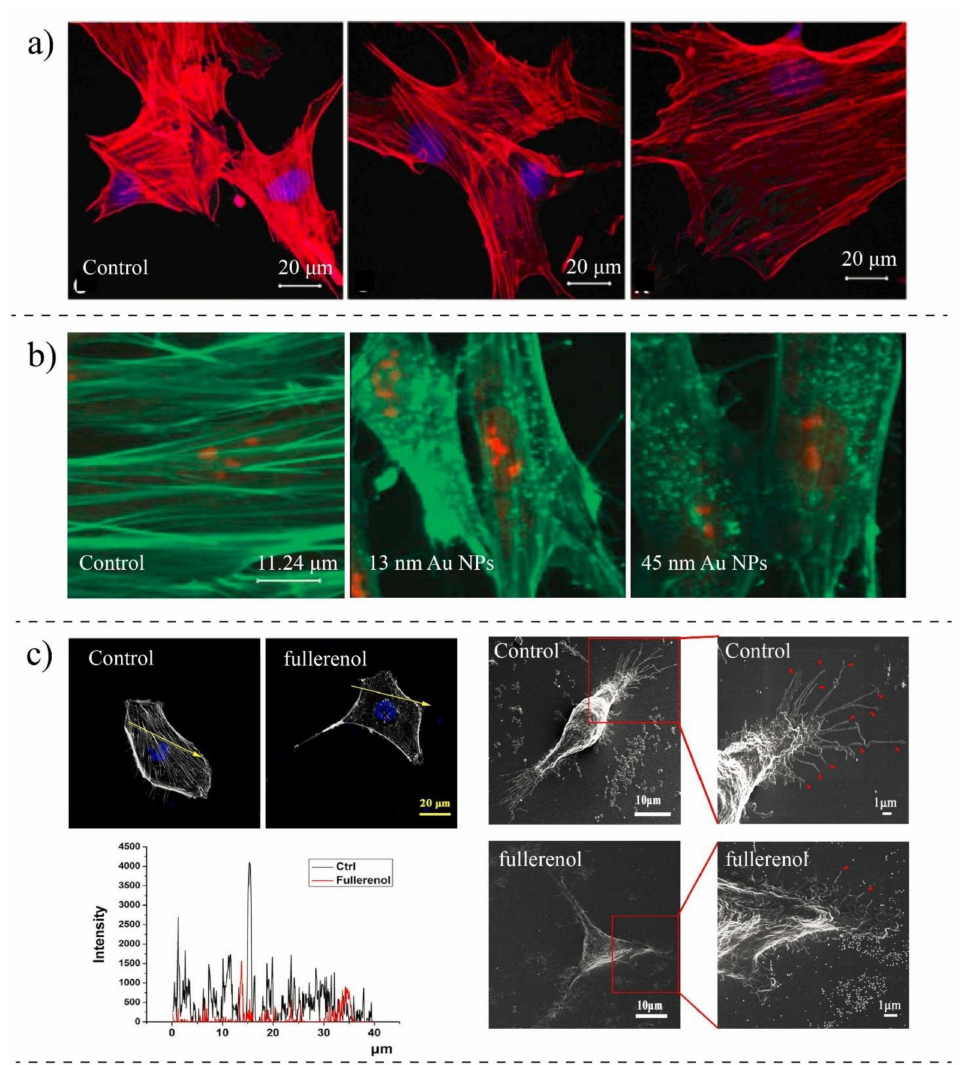
Figure 7. ( a ) Mesenchymal stem cells treated with silica (Si) and silica–boron (SiB): F-actin detected with red TRITC- phalloidin staining, and DNA stained with blue DAPI. Actins in control cells are packed longitudinally, while they are arranged transversally in treated cells [148]. Copyright 2014, Open Access Springer Journals. ( b ) Fluorescent imaging of human dermal fibroblasts stained for F-actin after three days exposure to gold NPs. F-actins appeared to be in dotted format compared to control cells. Reprinted with permission from [37]. Copyright Informa UK Ltd. 2010. ( c ) SEM images of MDA-MB-231 cells treated with fullerenol NPs compared to control cells. Treated cells show shorter protrusions in comparison to control cells, and the concentration of actin fibers has reduced after the uptake of NPs [151]. Copyright 2019, Open Access, Journal of